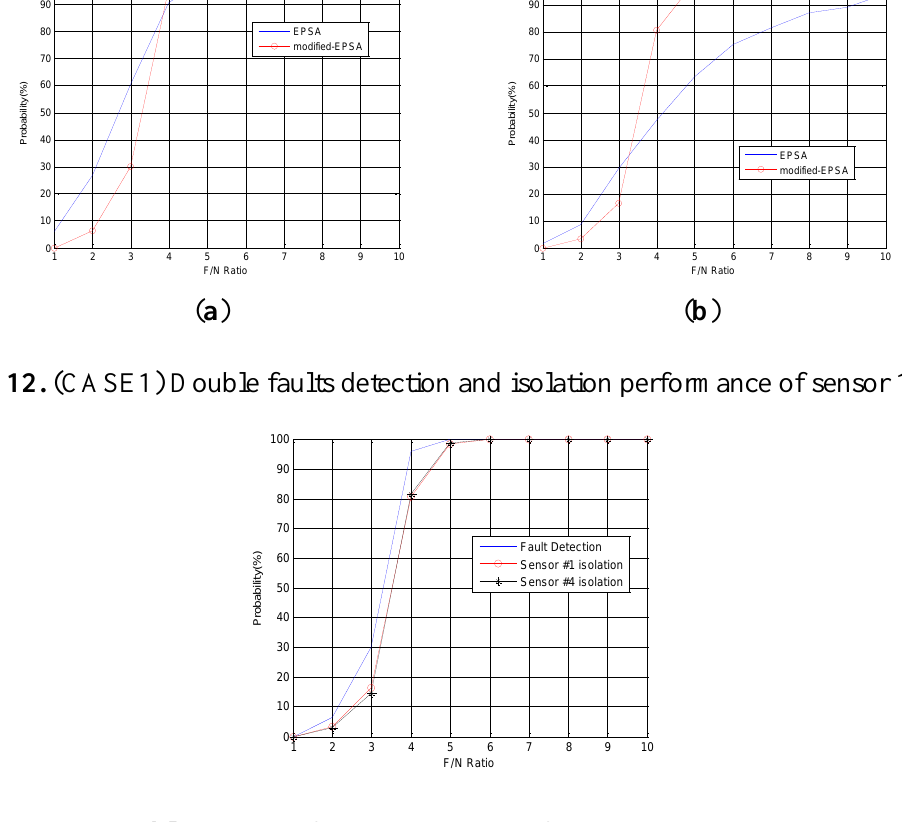
Table 4. Modidfied-EPSA FDI performance in